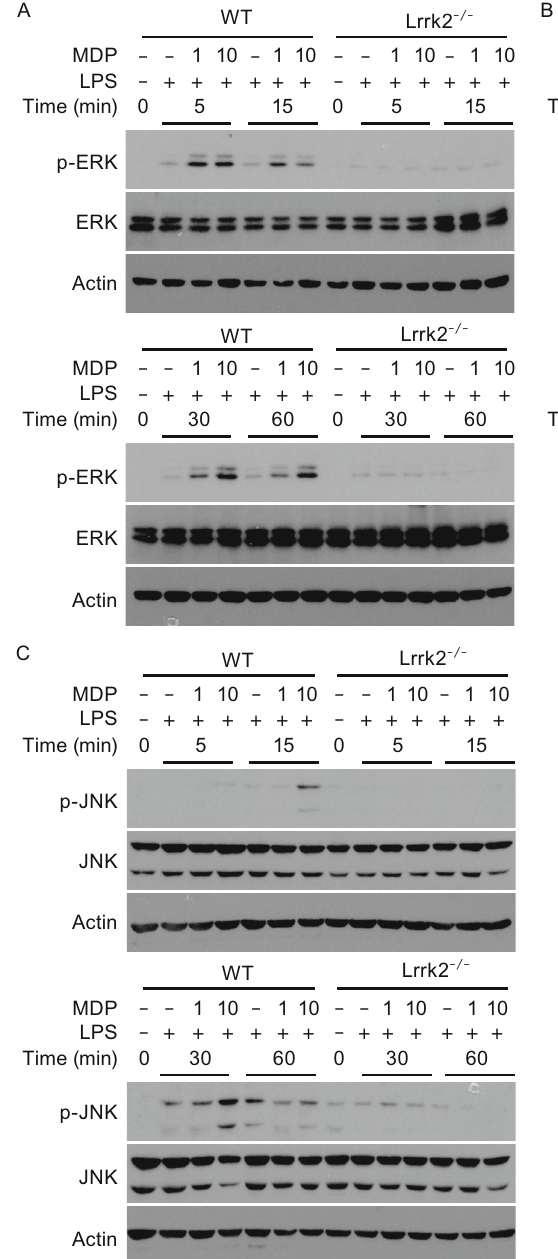
Figure 3. LRRK2 modulates MAPK pathways in BMDMs. The levels of phosphorylated ERK1/2 (A), phosphorylated P38 (B) and phosphorylated JNK (C) were determined by immunoblotting of lysates from WTand Lrrk2 − / − BMDMs treated with 5 ng/mL LPS and 1 or 10 μ g/mL MDP for the indicated times. The total amounts of ERK1/2 (A), P38 (B) and JNK (C) were also analyzed. Actin was used as a loading control. Data are representative of three independent experiments (A –